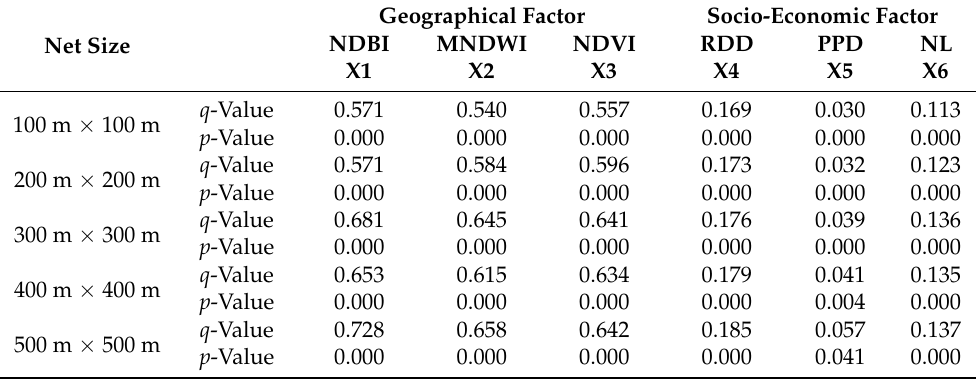
Table A1. Single-Factor optimal scale